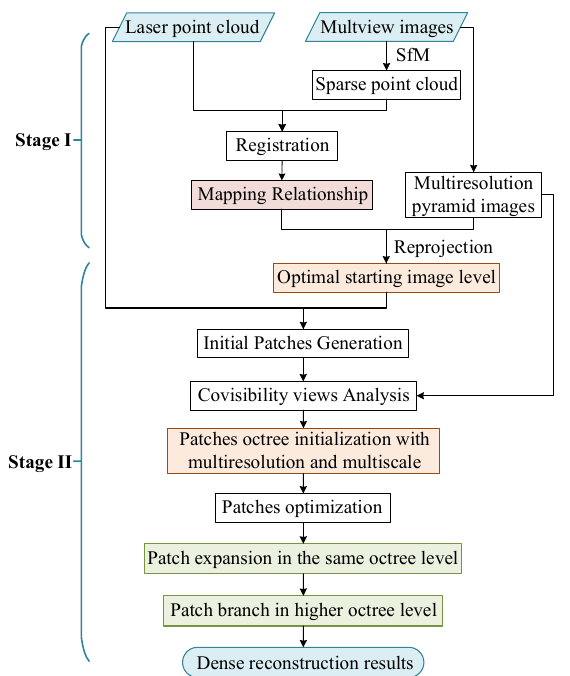
Figure 3. Flowchart of the proposed method.